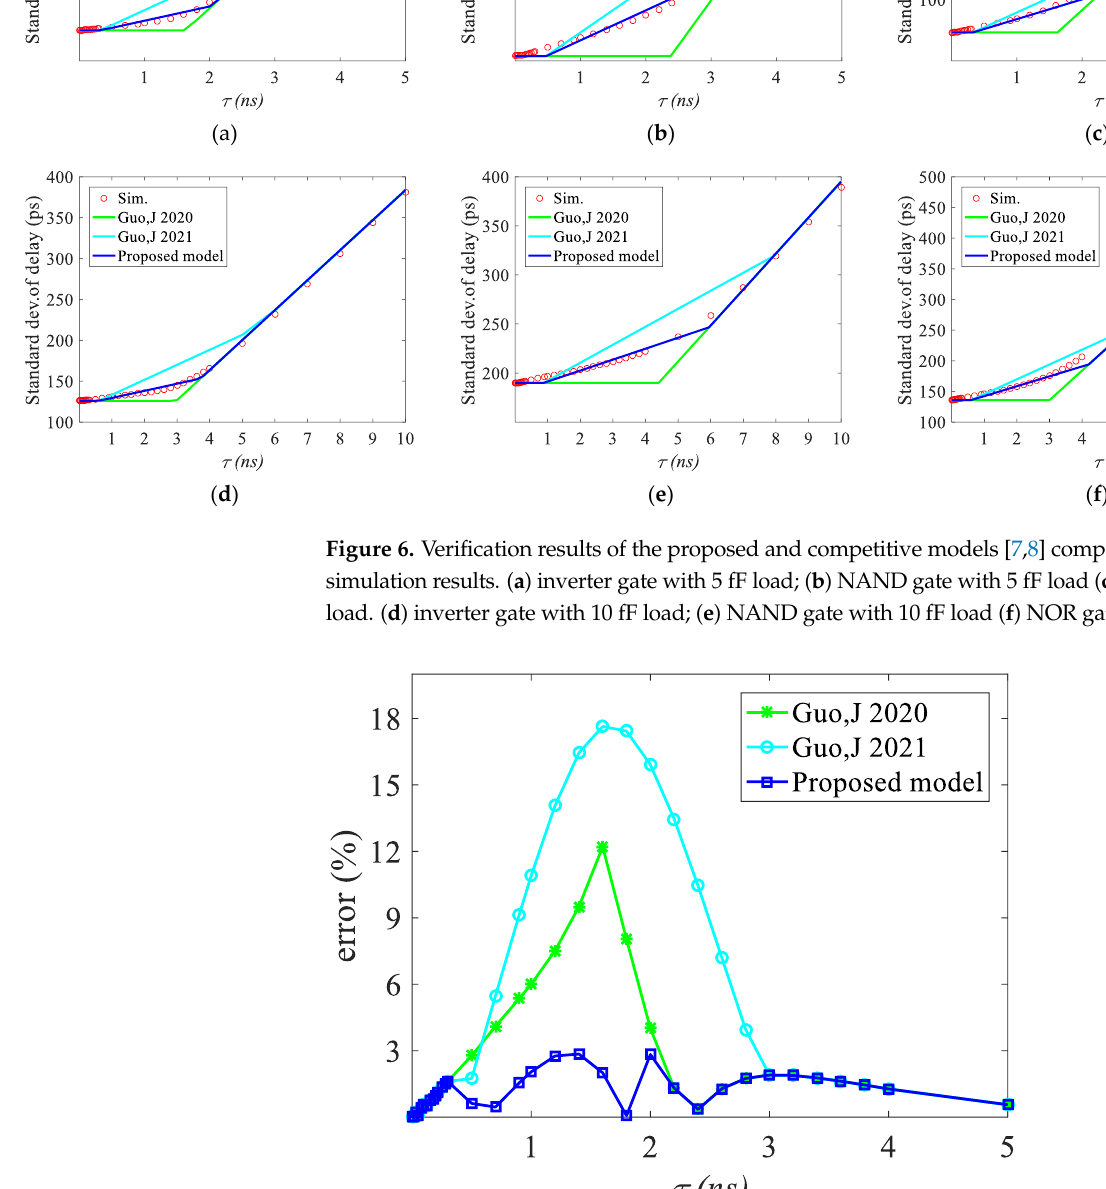
Figure 7. Model error comparison with [7,8] for inverter delay with load 5 fF.